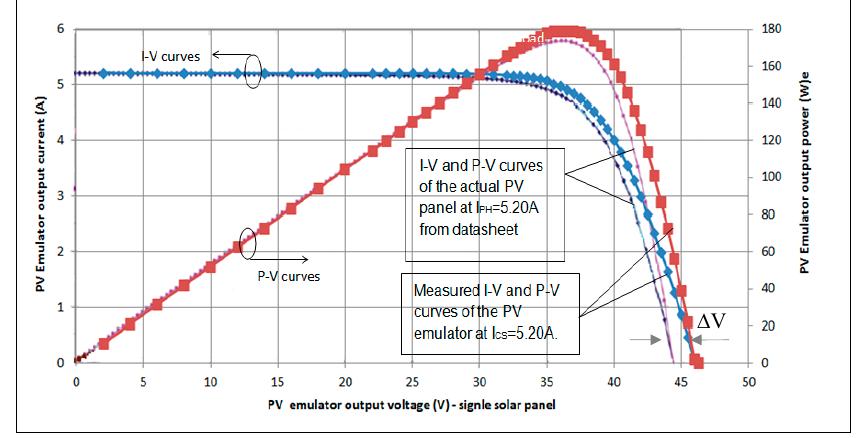
Figure 15. Comparison of the electrical characteristic between the emulated PV source at I cs = 5.20 A and the actual solar panel at STC (1000 W/m 2 , 25 °C).